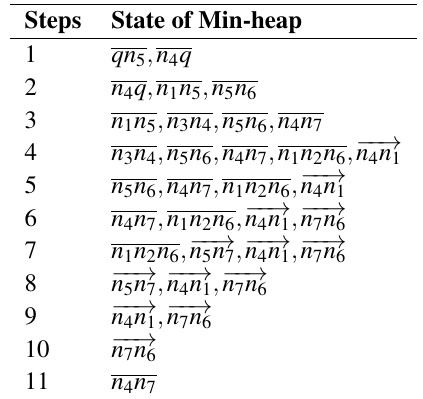
Table 2. Summary of